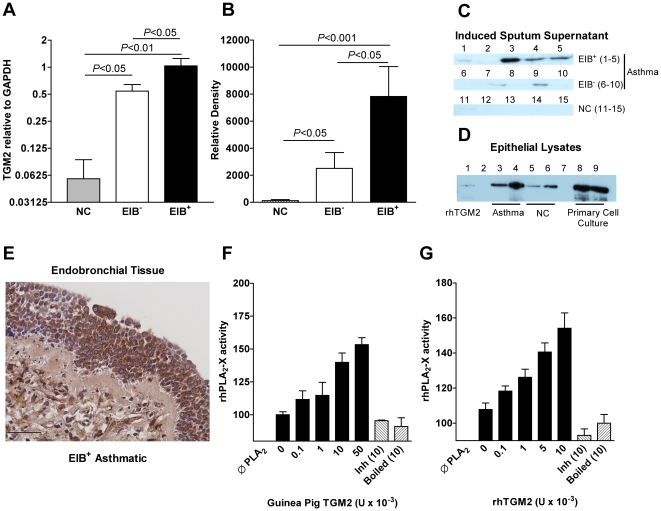
Comparison of TGM2 levels in the airways and in vitro function of TGM2 in the activation of secreted PLA2 activity.The gene expression of TGM2 by qPCR in airway cells was increased in both asthma groups relative to non-asthmatic controls, and the expression was higher in the EIB+ group (A). TGM2 was not detected in induced sputum supernatant from non-asthmatic controls, but was elevated in asthmatics, especially in the EIB+ group (B). The bands from one of two Western blots used to quantify the levels of TGM2 in induced sputum supernatant are shown in the panel, with lanes 1–5 representing EIB+ asthmatics, lanes 6–10 representing EIB− asthmatics, and lanes 11–15 normal controls (C). A Western blot of epithelial brushings from asthmatics demonstrates higher levels in the epithelium from asthmatics relative to non-asthmatic controls (D). In the blot, the first lane is recombinant human TGM2 (rhTGM2), lanes 3 and 4 are epithelial lysates from 2 different EIB+ asthmatics, and lanes 5 and 6 are epithelial lysates from 2 different normal controls. Asthmatic epithelial cells from an EIB+ asthmatic in primary culture shown in lanes 8 and 9 also strongly express TGM2. Immunostaining for TGM2 in airway biopsies from an EIB+ asthmatic demonstrates immunostaining in the airway epithelium for TGM2 (40×, scale bar is 50 µm) (E). Pre-incubation of recombinant human sPLA2-X with purified TGM2 from guinea pig liver (F) or with recombinant human TGM2 (G) causes an increase in the PLA2 activity of the sPLA2-X enzyme. Denaturing the TGM2 with heat (boiled) or inhibiting the activity of the enzyme by saturating the enzyme with N-carbobenzoxy-Gln-Gly (Inh) demonstrate that the in vitro findings are due to the enzymatic activity of TGM2.